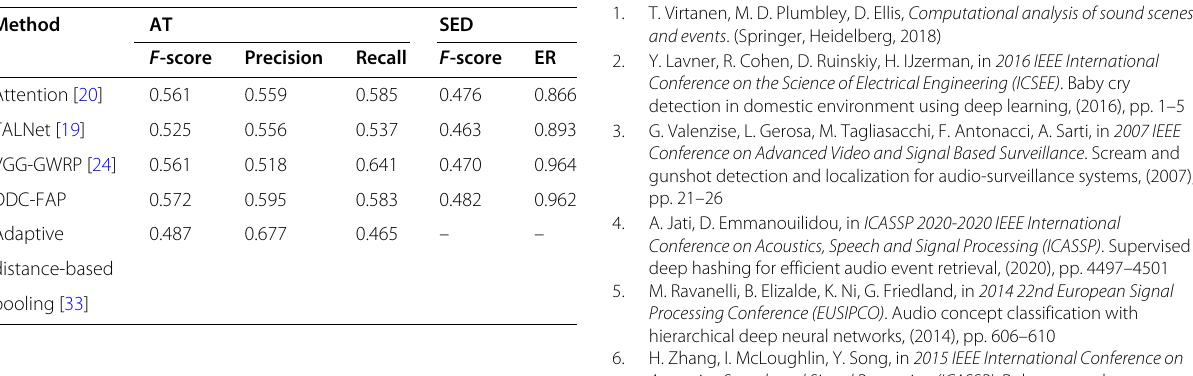
Table 8 The results of DCASE 2017 Task 4